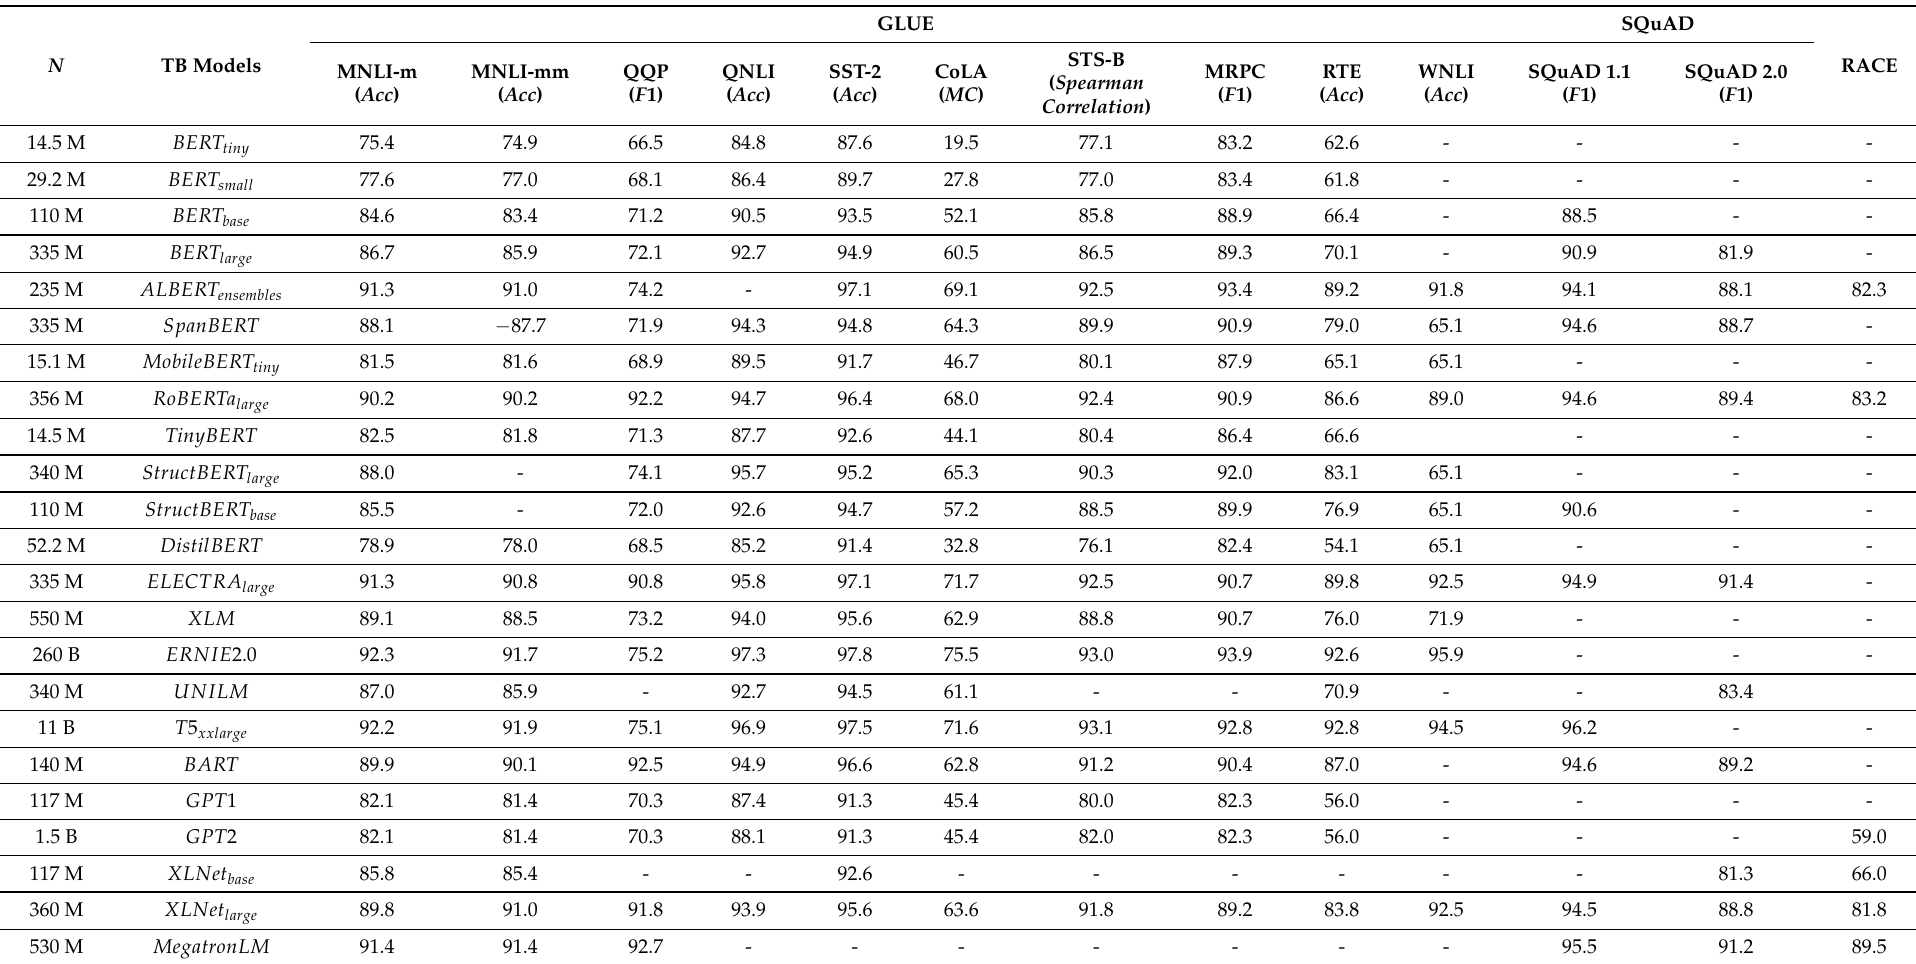
Table 4. List of evaluation results for examples of TB state-of-the-art models on NLP benchmarks, where N referes to the number of parameters of the TB